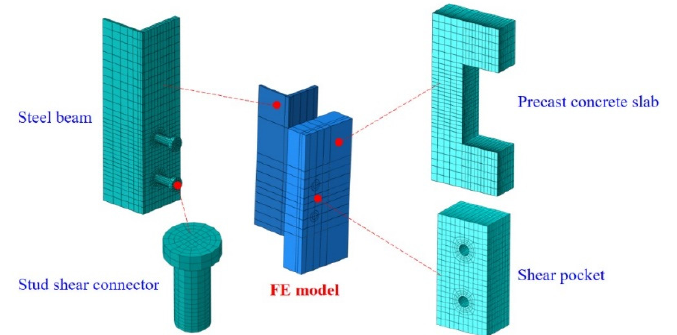
Figure 7. Overall FE model of the push-out test.